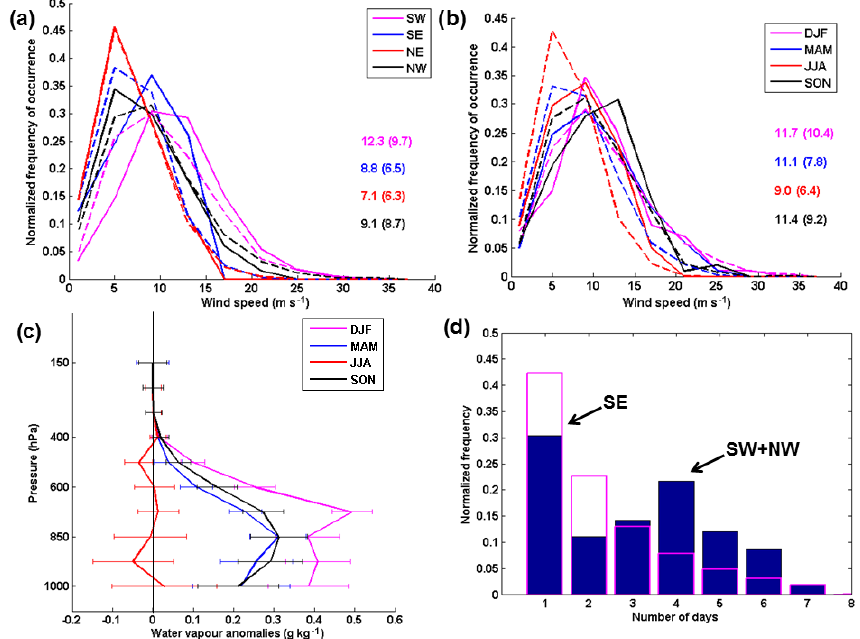
Figure 7. (a) Histograms of wind speeds (ms − 1 ) at 850hPa over the centre of the study area (55–60 ◦ N, 11–20 ◦ E) during extreme events (solid lines) and climatological conditions (dashed lines, 2004–2015) when data are partitioned for different wind directions. The numbers show average wind speeds (ms − 1 ) during extreme events and in brackets under climatological conditions. (b) Same as in (a) , but when wind data are partitioned for different seasons. (c) Vertical anomalies of specific humidity (gkg − 1 ) during extreme events with horizontal bars showing standard deviations. (d) Persistency of wind directions as a function of number of continuous days. The magenta bars show persistency under climatological conditions.